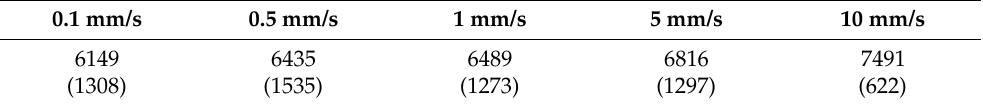
Table A1. Stress–strain ratio (MPa) of the load-to-failure test fitted by the linear model for the 5 groups at a different loading velocity. Values are given as mean